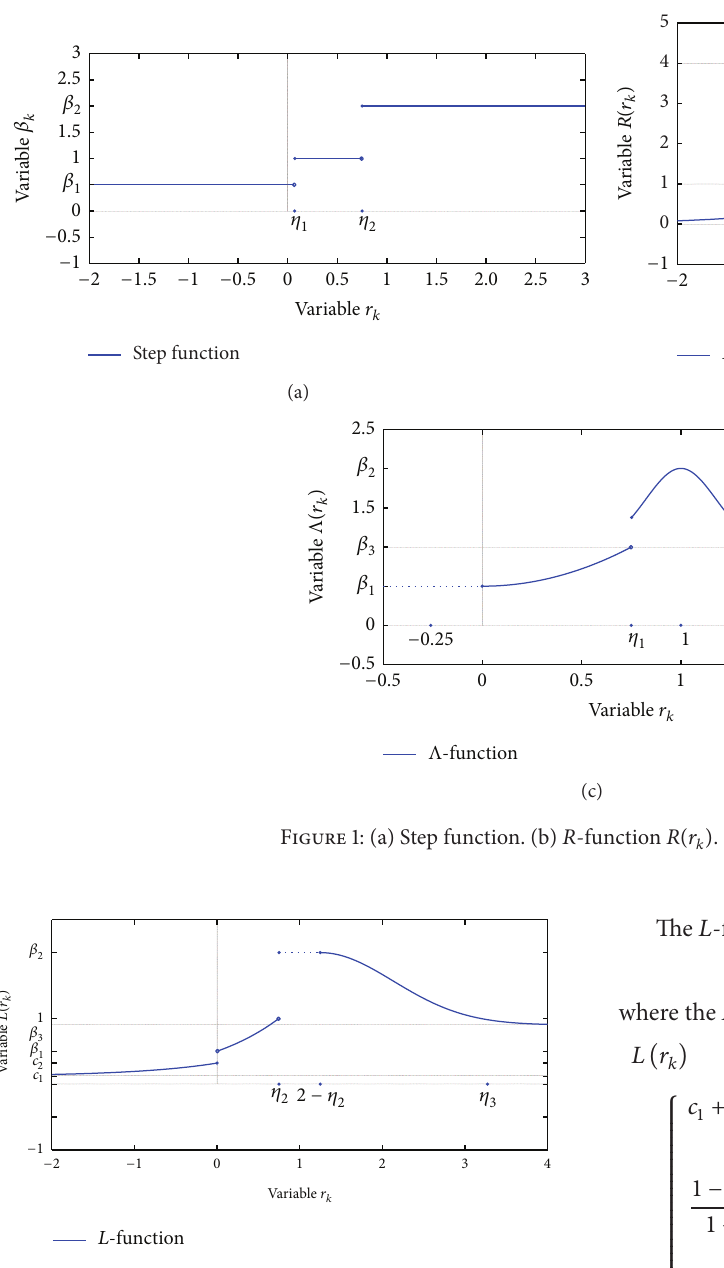
Figure 2: 𝐿 -function 𝐿(𝑡)